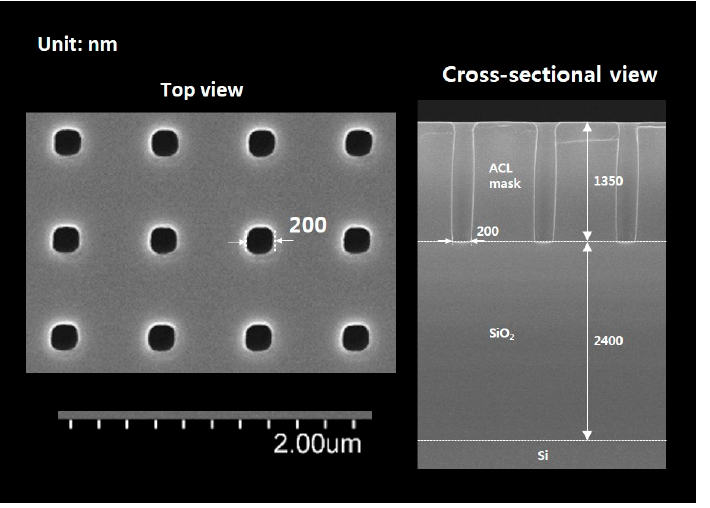
Figure 2. Top and cross ‐ sectional SEM images of the 200 nm diameter hole ‐ patterned sample.